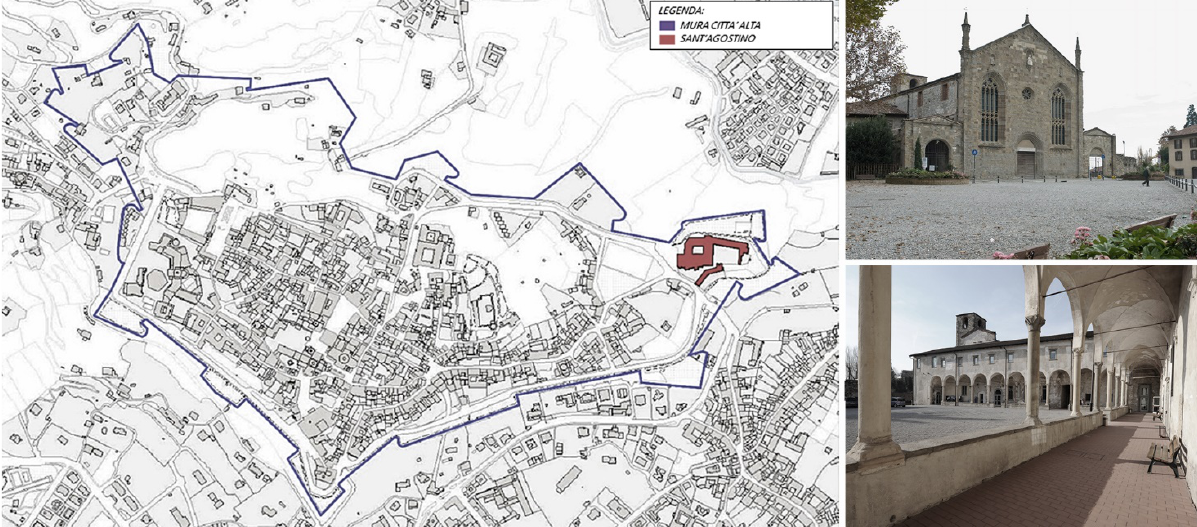
Figure 1. On the left, the layout of the Venetian city walls and the former convent. On the right, from top to bottom, the great cloister of the monastery and the façade of the church.